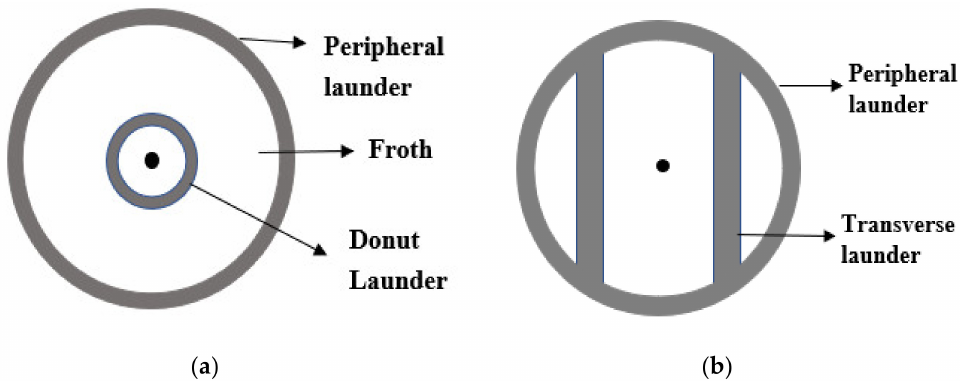
Figure 3. ( a ) Donut launder [14]; ( b ) Transverse launder [11]. Transverse